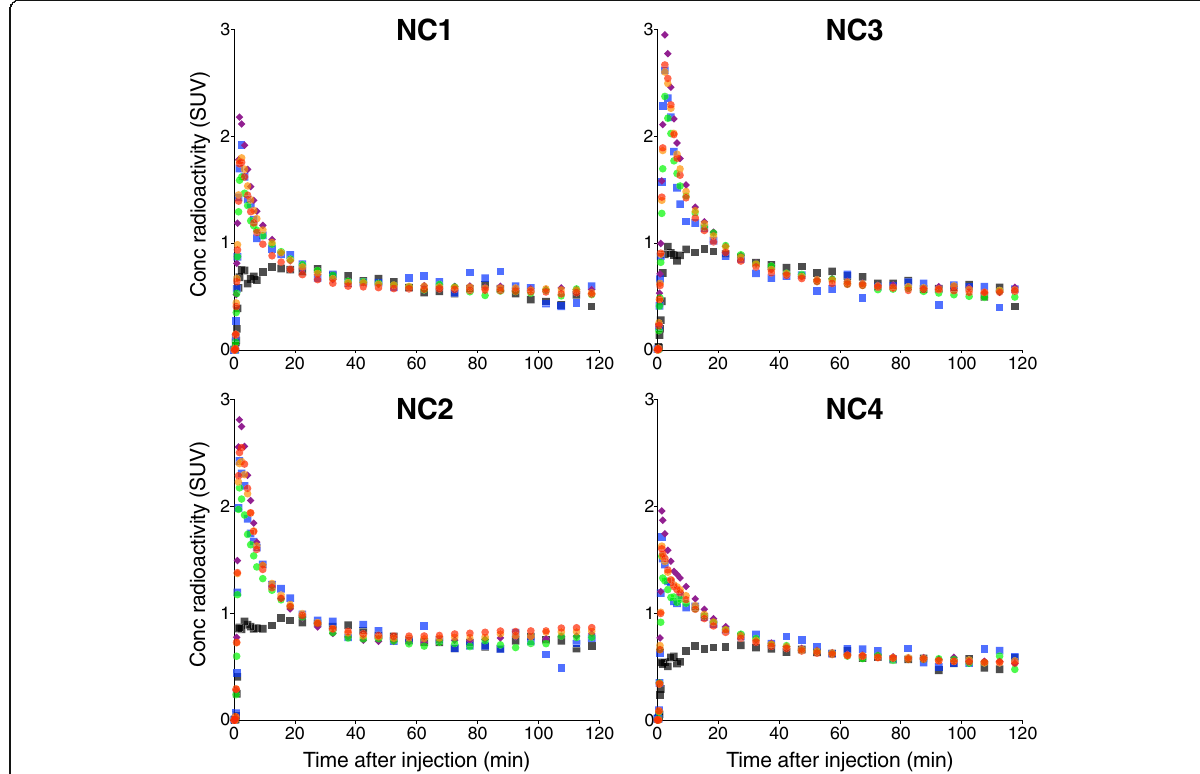
Fig. 2 Time course of radioactivity in the frontal cortex ( red ), temporal cortex ( orange ), hippocampus ( green ), cerebellum ( purple ), pons ( blue ), and centrum semiovale ( black ) after injection of [ 11 C]HMS011 in four subjects